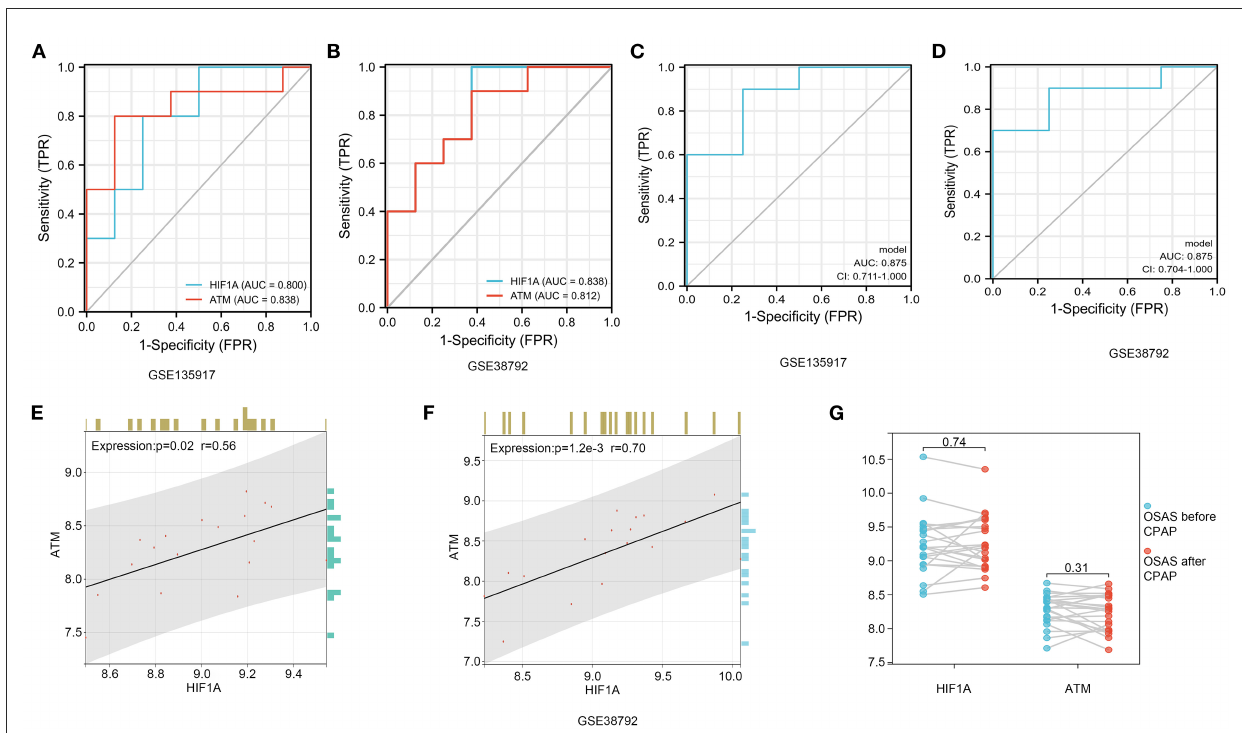
FIGURE8 HIF1A and ATM diagnosis curves, expression correlation analysis, and non-invasive ventilator pairing therapy modification. (A, B) In GSE135917 and GSE38792 datasets, HIF1A, and ATM expression were examined for ROC. (C, D) HIF1A and ATM combined models in GSE135917 and GSE38792 datasets. (E, F) The person correlation analysis of HIF1A and ATM. (G) Differential expression of HIF1A and ATM before and after non-invasive ventilator (CPAP) treatment in